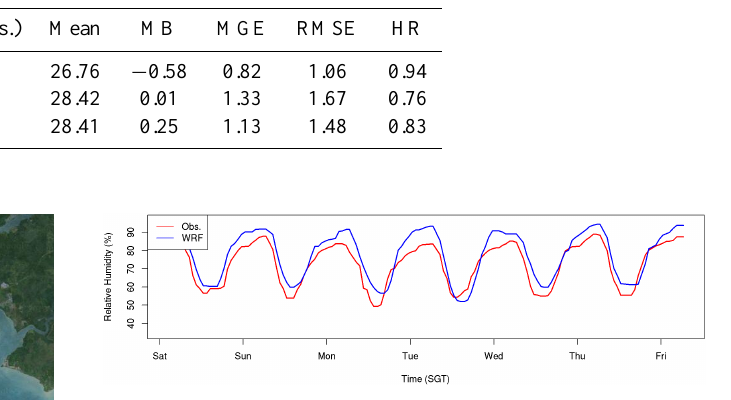
Table 4. Comparison between the hourly average observed and simulated temperatures for a period of one week in each monsoon and inter-monsoon seasons.